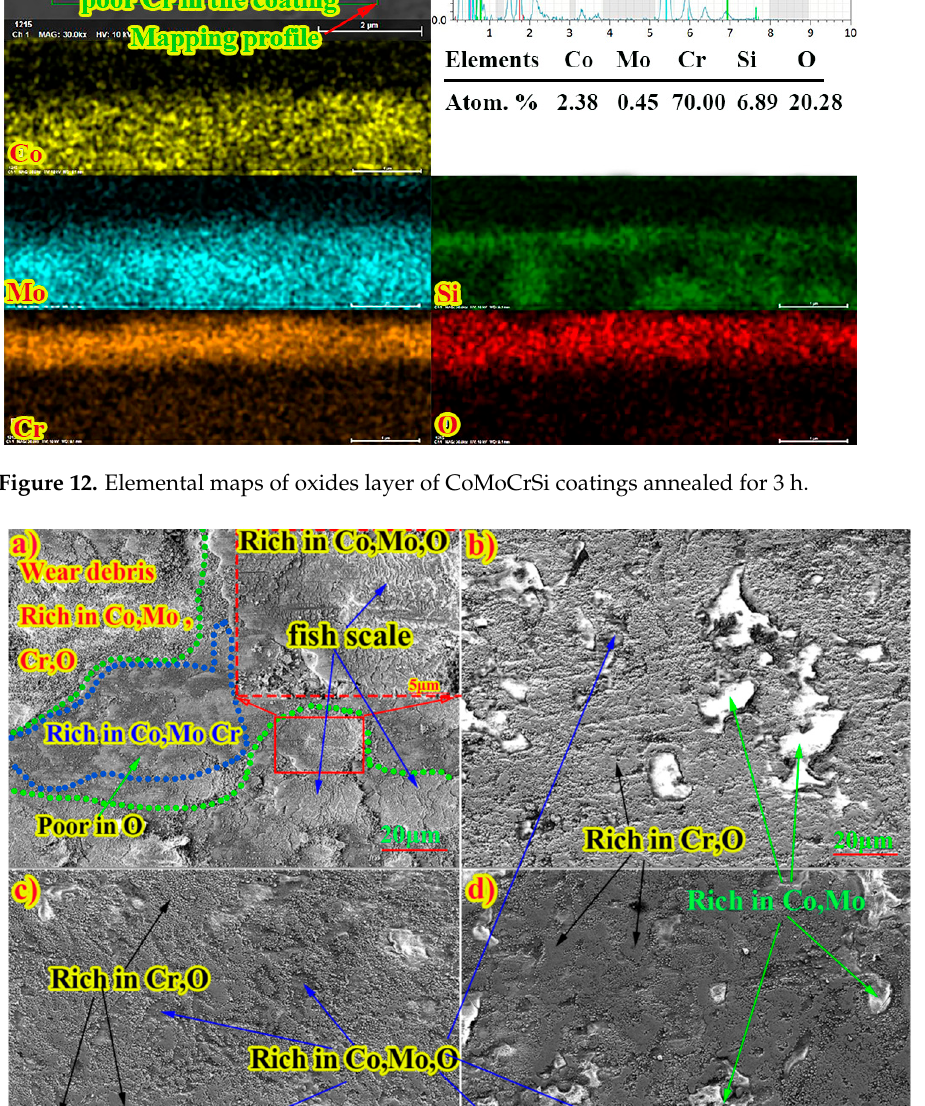
Figure 13. Worn surface of as-sprayed CoMoCrSi coatings ( a ) and coatings annealed for 3 h ( b ), 5 h ( c ), and 10 h ( d ).